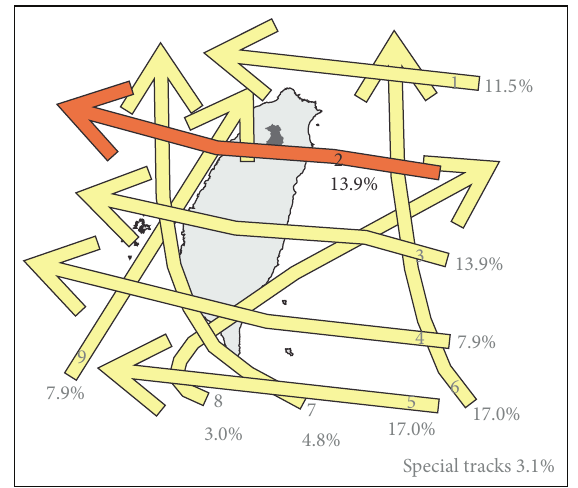
Figure 1: Schematic diagram of typhoon tracks invading Taiwan. The percentages in the figure were the statistic results from 1958 through 2006 by the Central Weather Bureau (CWB). The dark grey polygon located in the northern Taiwan indicates the Shihmen Reservoir catchment. Typhoons in type 2 would pass through the Shihmen Reservoir catchment and bring heavy rainfall, such as Typhoon Saola in 2012 or Typhoon Soulik in